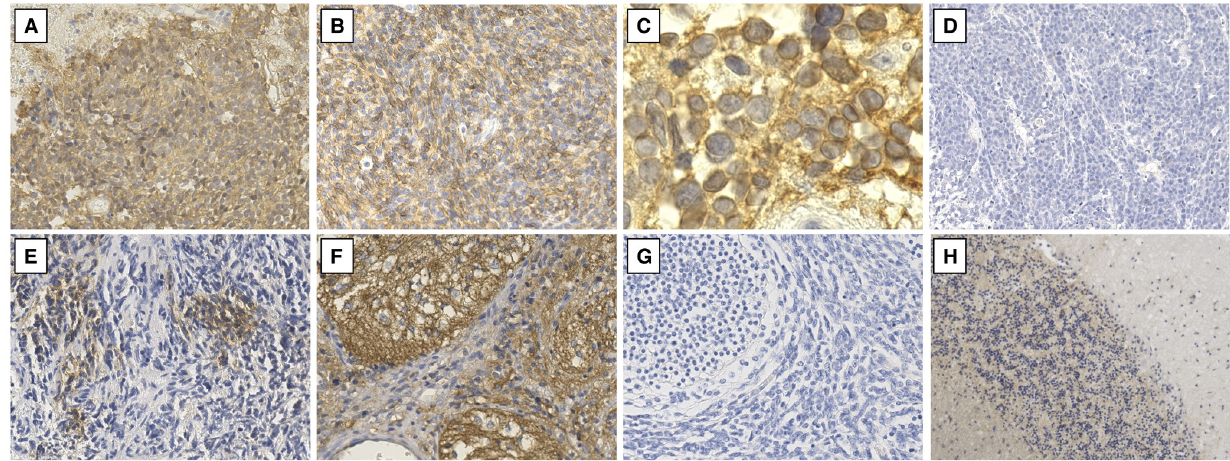
Fig 2. Immunohistochemical staining of ALCAM in medulloblastoma (MB) specimens. (A, B) ALCAM-positive cases: the WNT subgroup showed diffuse positive staining of ALCAM. (C) Most of the ALCAM-positive cells stained predominantly in the cytoplasm. (D) An ALCAM-negative case. (E) A partially positive case of ALCAM staining: few scattered ALCAM-positive cells can be observed. (F) The MBEN histological variant demonstrated a different ALCAM expression profile: positive staining in the lobular architectural region and negative in the internodular region. (G) The desmoplastic/ nodular variant showed no ALCAM expression in most of the pale nodular areas and internodular areas. (H) In normal cerebellar tissue, the expression of ALCAM is not observed in the molecular layer, but is weakly detected in the granular layer and white matter. Original magnification, × 200 (A, B, D–G), × 1,000 (C) and × 100 (H).